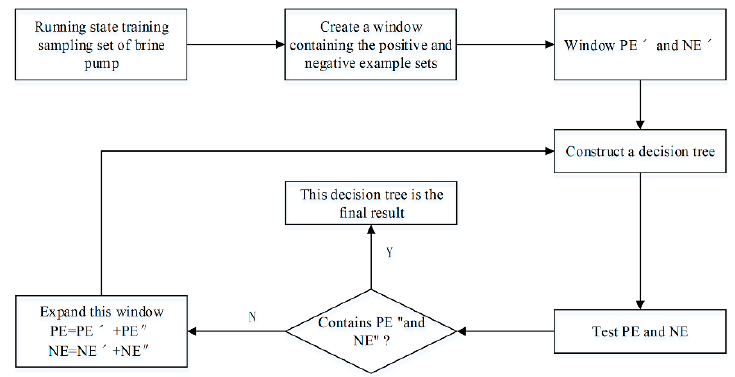
Figure 6. ID3 main algorithm flow chart.